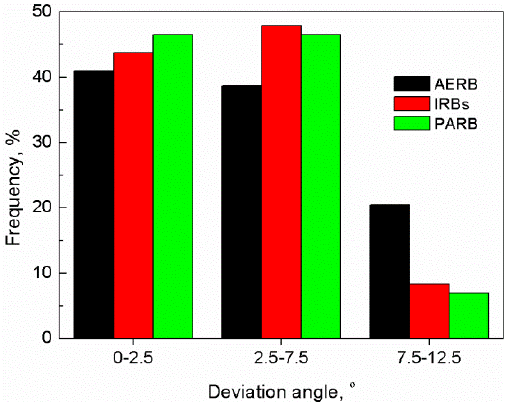
Figure 14. Predicted distributions of deviation angle between <001> direction of grains and withdrawal direction of mold at casting height of 100 mm. AERB: adjusted external radiation baffle; IRBs: inner radiation baffles; PARB: perfectly adjusted radiation baffle.